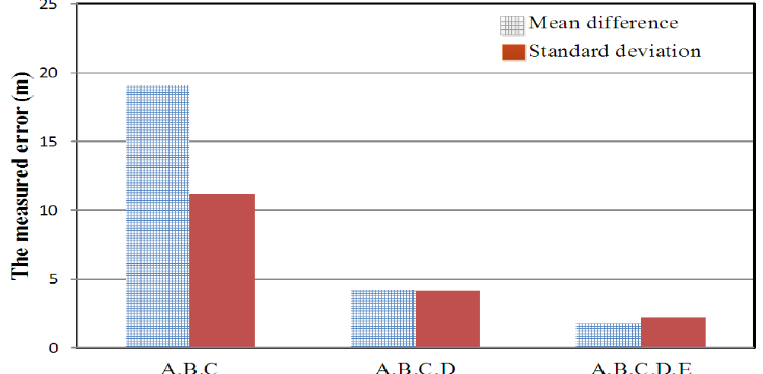
Figure 12. The locating accuracy by using the proposed genetic algorithm in a 3D free space environment.